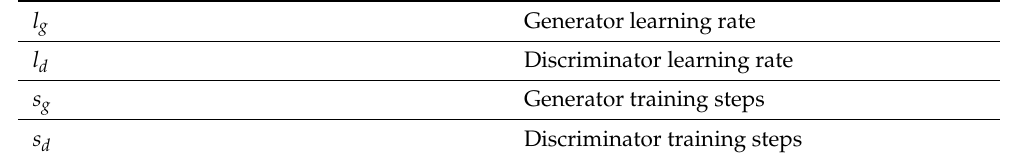
Table 1. Training parameters.